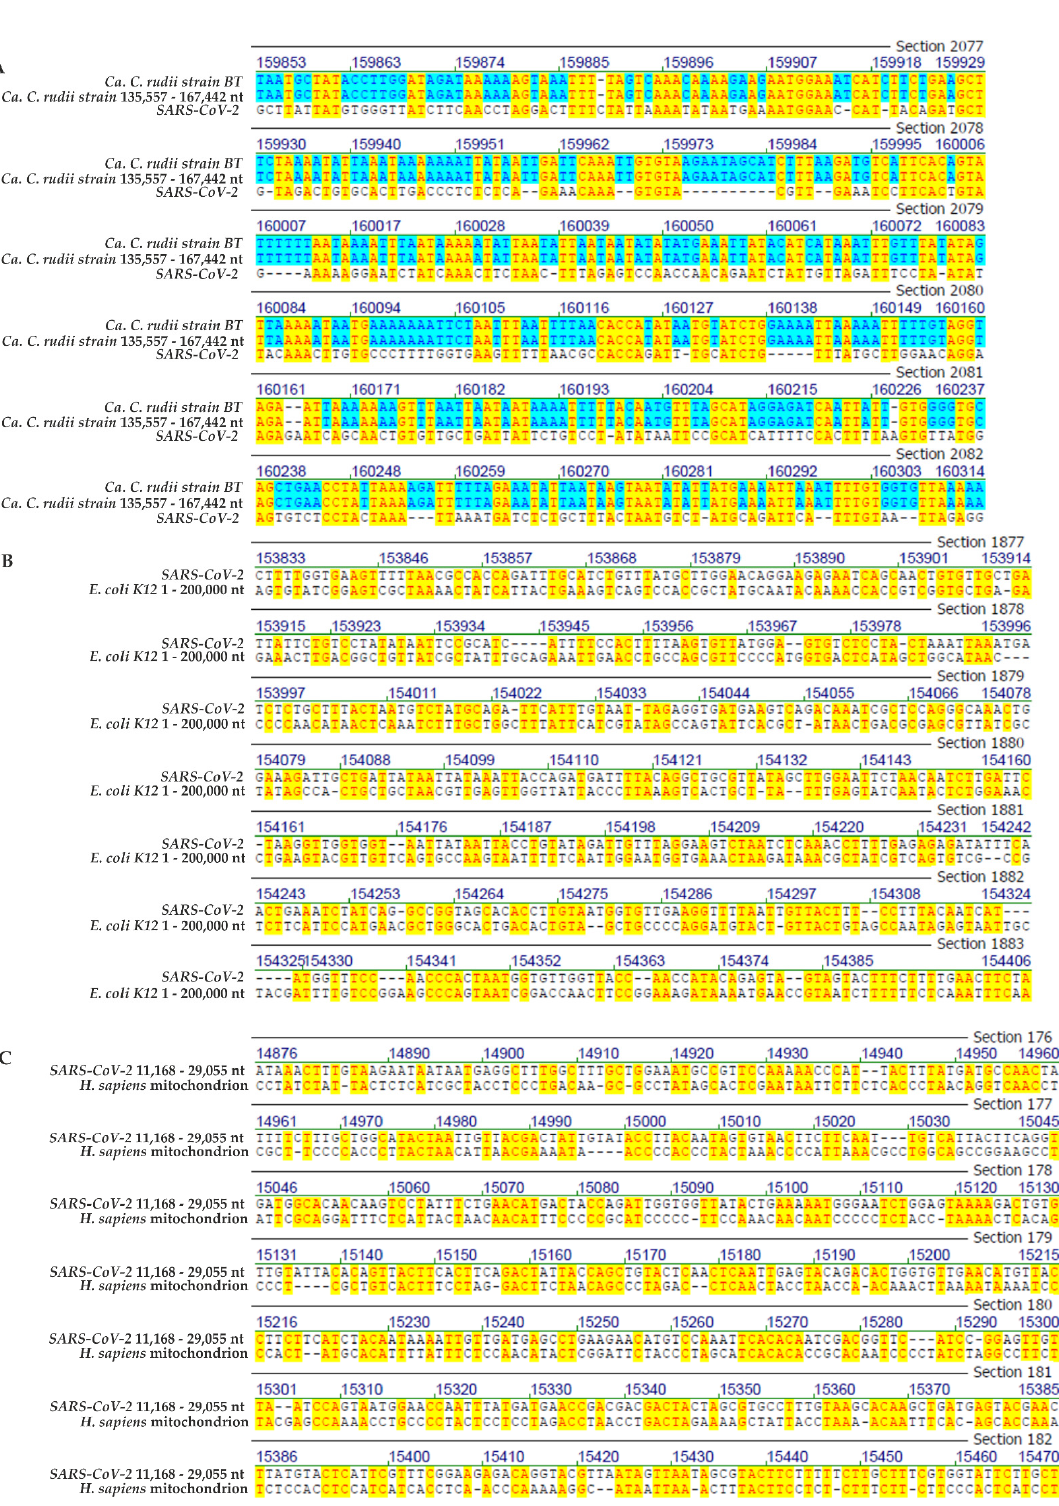
Figure 4. ( A ) Sequence alignment between Wuhan SARS-CoV-2 and Candidatus Carsonella ruddii . ( B ) Sequence alignment between Wuhan SARS-CoV-2 and E. coli K12 . ( C ) Sequence alignment between Wuhan SARS-CoV-2 and human mitochondrial DNA. The yellow highlight designates sequence identities between the genomes of SARS-CoV-2 and two segments of the proteobacterium Candidatus Carsonella ruddii ( A ), a segment of the Escherichia coli K12 genome ( B ) or mitochondrial DNA of Homo sapiens ( C ). The blue highlight stands for sequence identities between the nucleotide sequences of two different segments of the Candidatus Carsonella ruddii genome